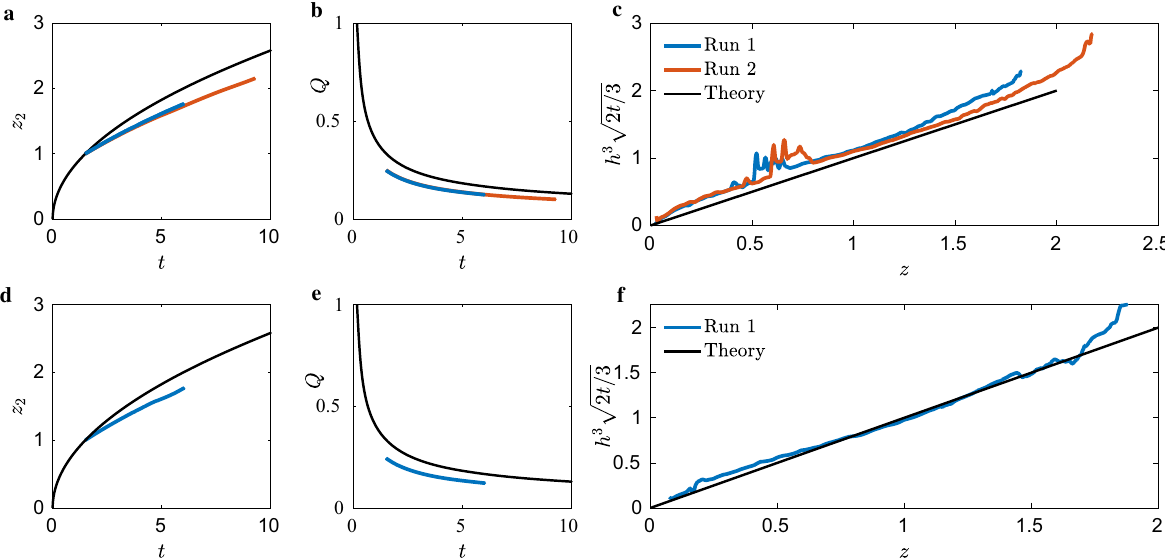
Fig. 8 ICF-4 data. a – c Small-end and d – f big-end drain. a , d present advancing bulk meniscus location z 2 ( t ), b , e volumetric fl ow rate Q ( t ), and c , f the self-similar time-averaged interface height pro fi le h 3 (2 t /3) 1/2 .